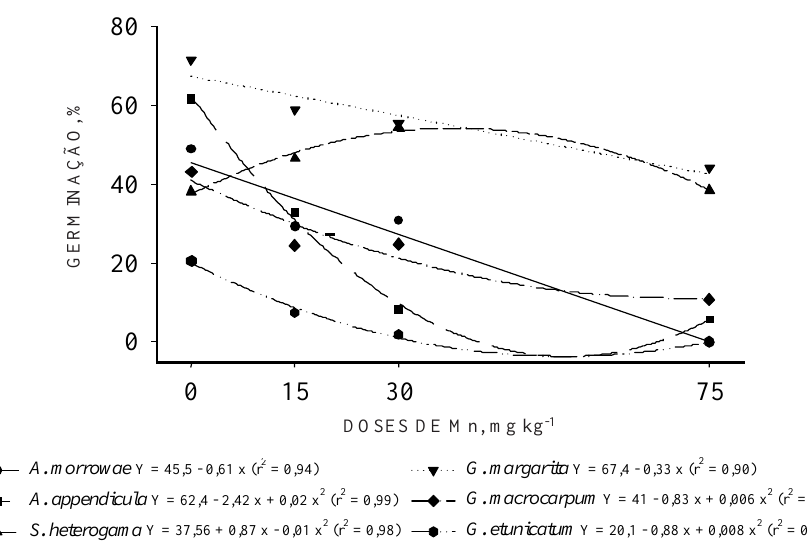
Figura 1. Germinação de esporos de seis espécies de fungos micorrízicos arbusculares, de acordo com doses de Mn adicionadas ao substrato. Barras verticais indicam DMS em cada dose de Mn; coeficientes das equações são significativos a P <